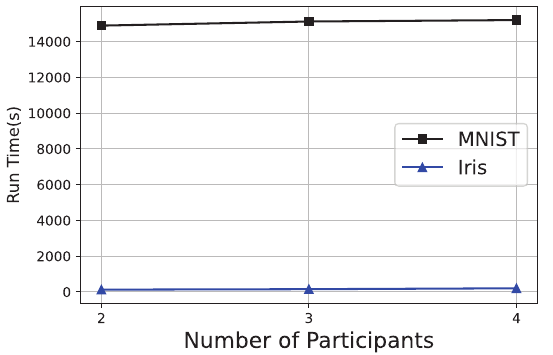
Figure 4. Running time of the SSXGB with the Iris and MNIST